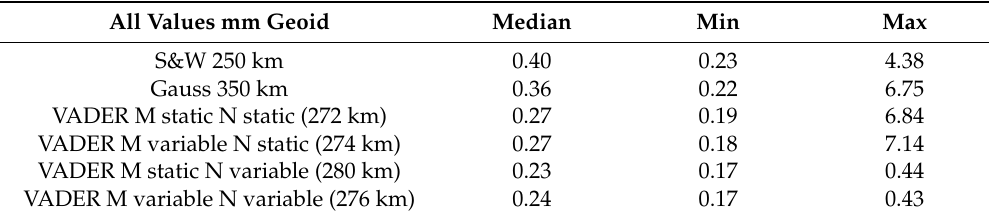
Table 2. Performance metrics for different post-processing methods are shown. Evaluation is based on the cumulative geoid error from residuals of a 143 month closed-loop time series. All values are given in